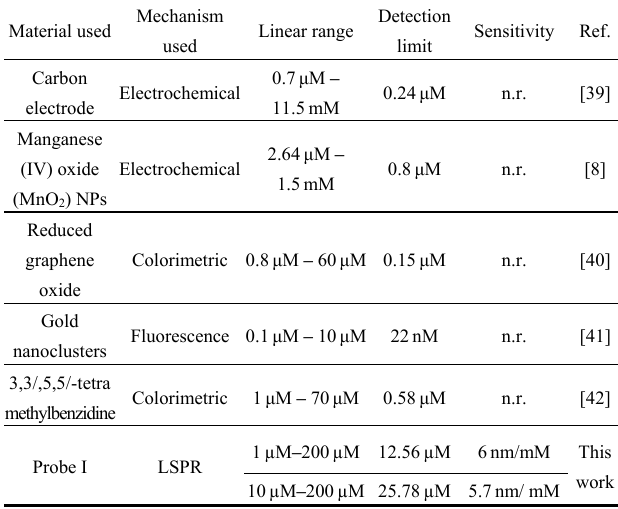
Table 1 Performance study of the proposed sensors. Mechanism Detection Material used Linear range Sensitivity used limit